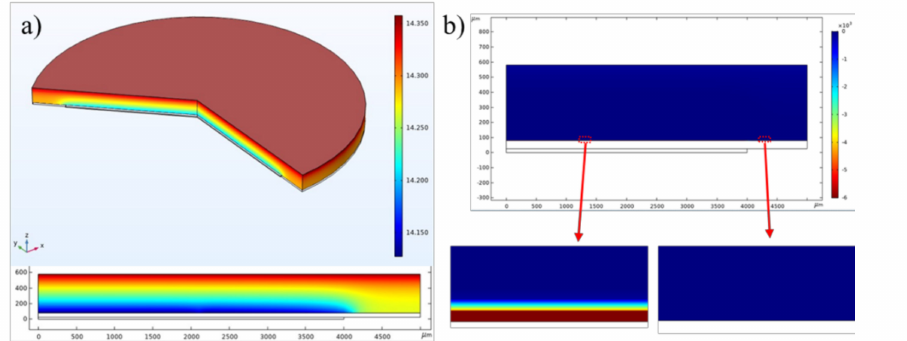
Figure 8. ( a ) Hydrogen concentration (mol/m 3 ) distribution within the composite anode. ( b ) The consumption rate of hydrogen R H2 within the composite anode (mol m − 3 s − 1